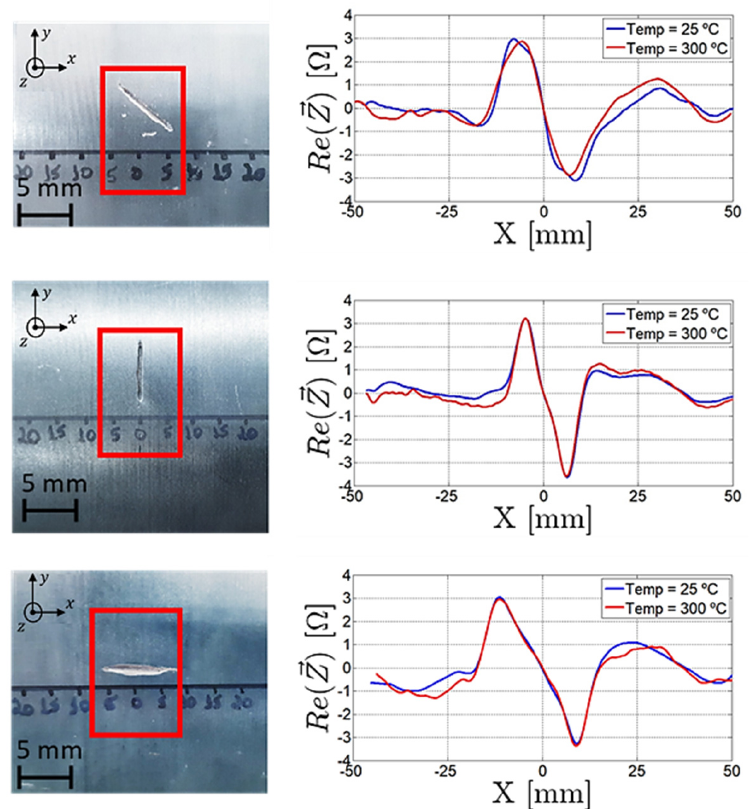
Figure 14. Output signal of the base material probe when scanning through the artificially made defect with different orientations.